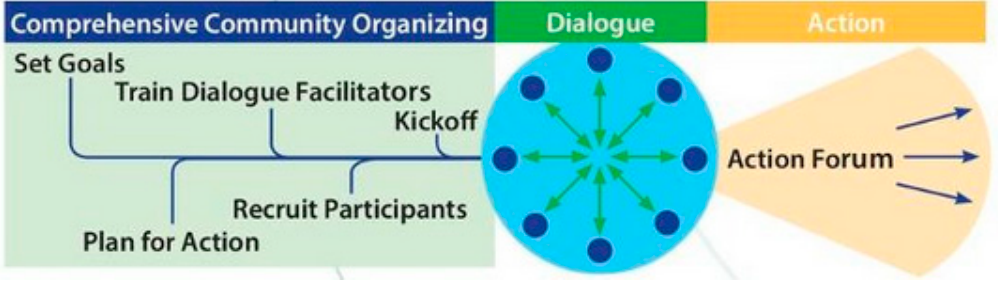
Figure 3. Study Circle Process. Source: www.everyday-democracy.org (A Guide for Training Public Dialogue Facilitators, 37).